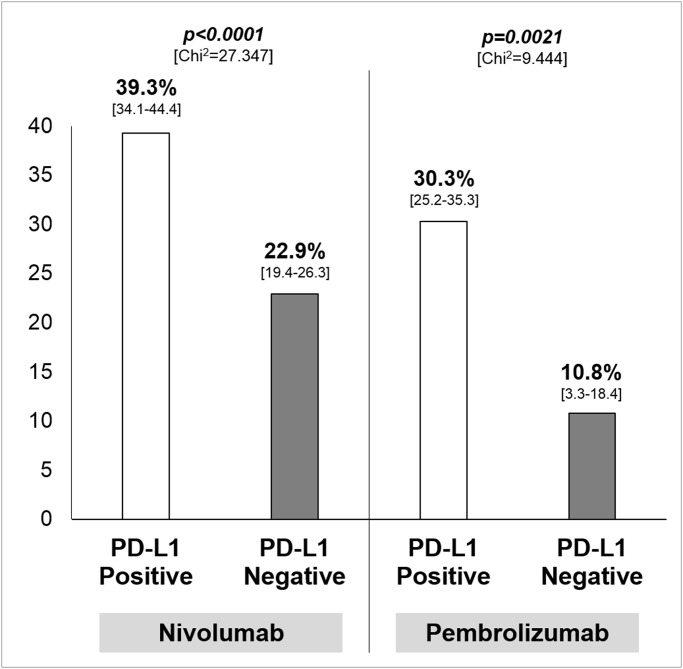
Results of the sensitivity analysis—Overall response rate, with 95% confidence interval in square brackets, according to adopted drug.Chi2: Chi-square test; PD-L1: programmed death-ligand-1.